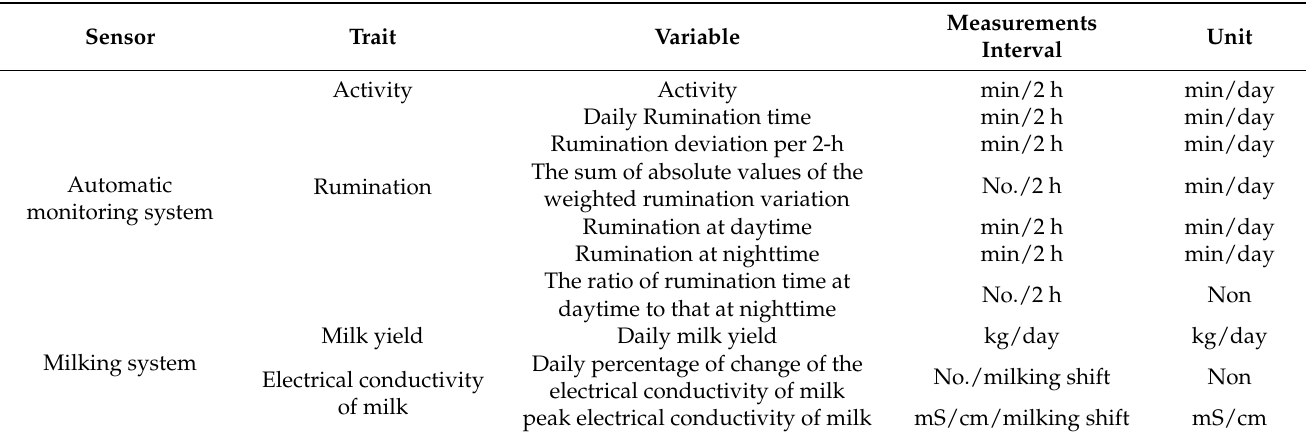
Table 1. Sources of information (automated monitoring system and milking system) and traits measured with variables at different measurement intervals, summed up to the daily